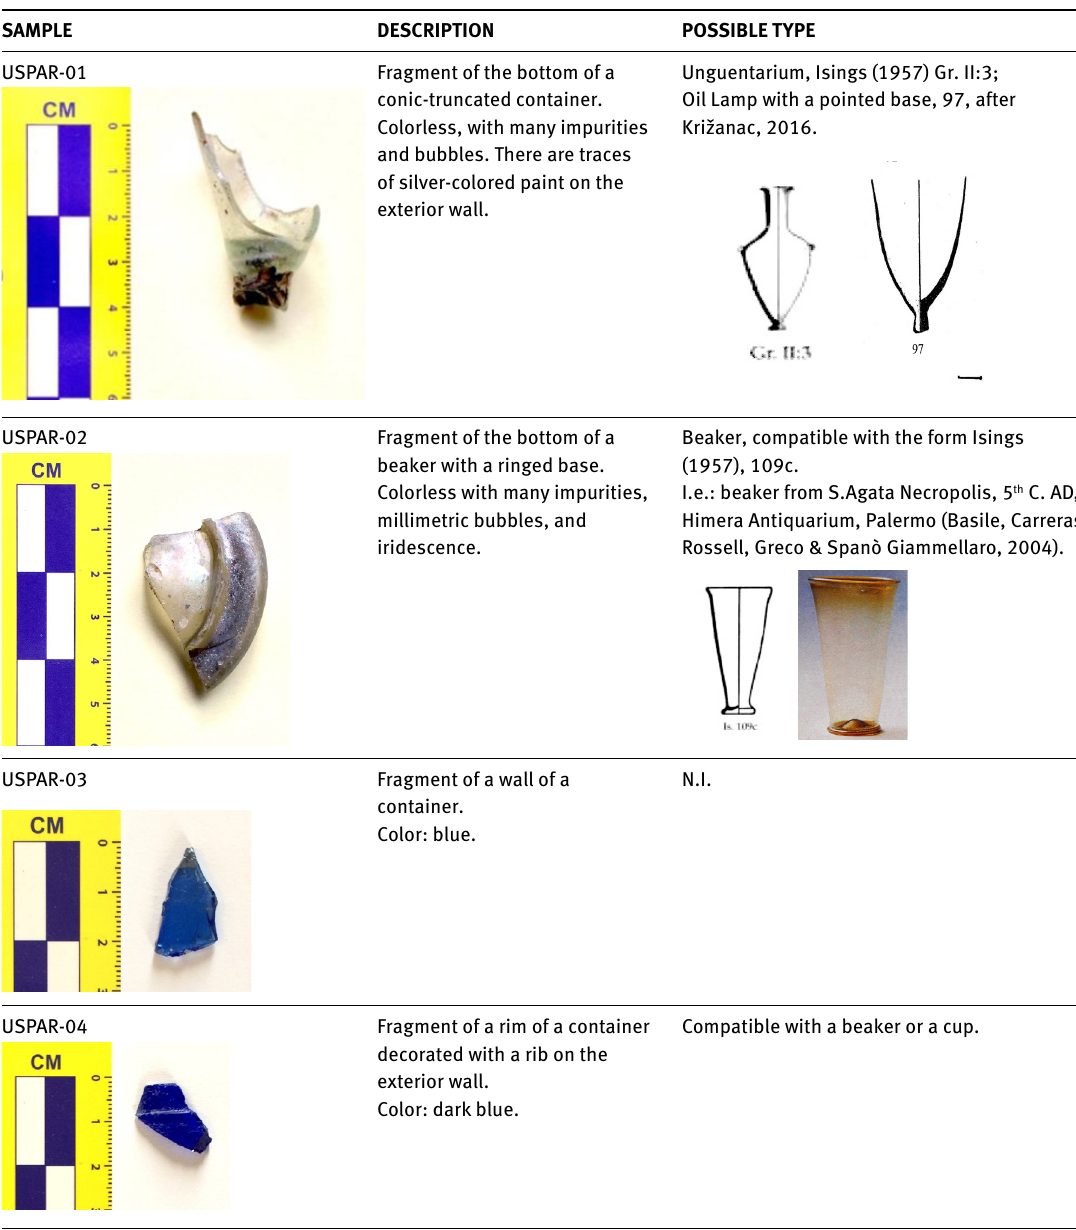
Table 3: Typological analyses (N.I. = Non